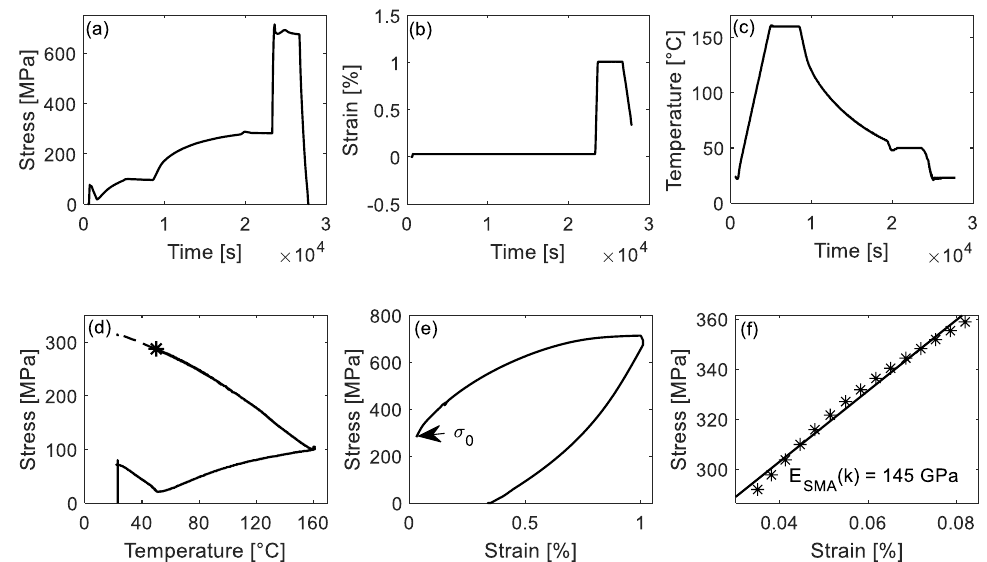
Figure 9. ( a – c ) Stress, strain, and temperature versus time curves of the interrupted experiments to determine E SMA ( 50 °C ↓ ). ( d ) Stress as a function of temperature during activation. The black star (50 °C ↓ ) marks the point, at which E SMA was evaluated. ( e ) Stress-strain curve during loading to 1% strain and unloading. ( f ) The linear fitting (regression line) in the stress range from σ 0 + 5 to σ 0 + 80 MPa.